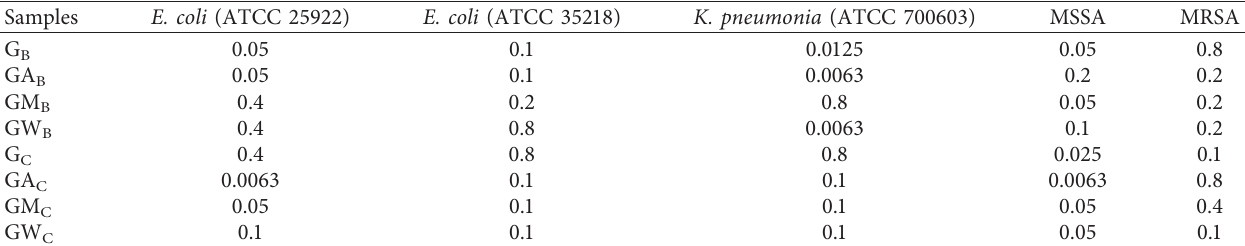
Table 1: Minimum inhibitory concentration (MIC) of biologically and chemically synthesized gold nanoparticles as well as their conjugates with P. grandiflora extracts.